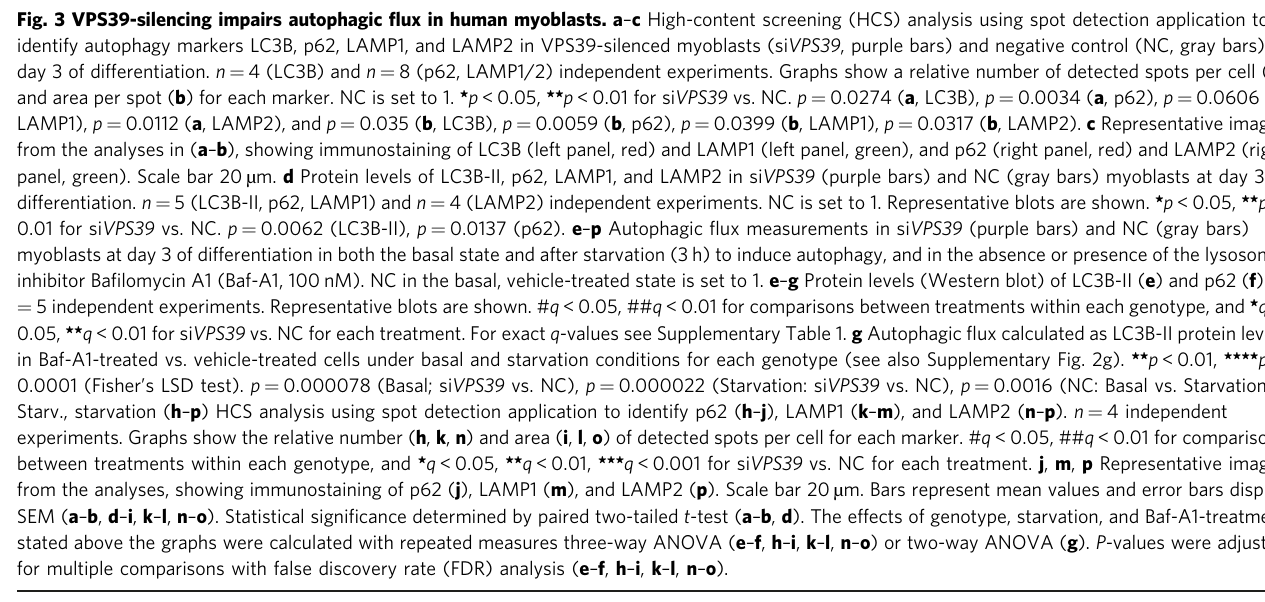
Fig. 3 VPS39-silencing impairs autophagic fl ux in human myoblasts. a – c High-content screening (HCS) analysis using spot detection application to identify autophagy markers LC3B, p62, LAMP1, and LAMP2 in VPS39-silenced myoblasts (si VPS39 , purple bars) and negative control (NC, gray bars) at day 3 of differentiation. n = 4 (LC3B) and n = 8 (p62, LAMP1/2) independent experiments. Graphs show a relative number of detected spots per cell ( a